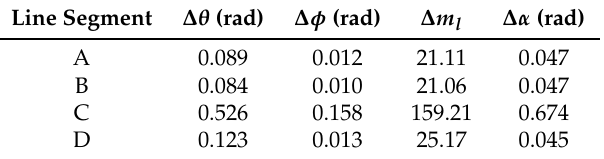
Table 2. The 95% confidence interval length of each component for line segment A, B, C, and D.